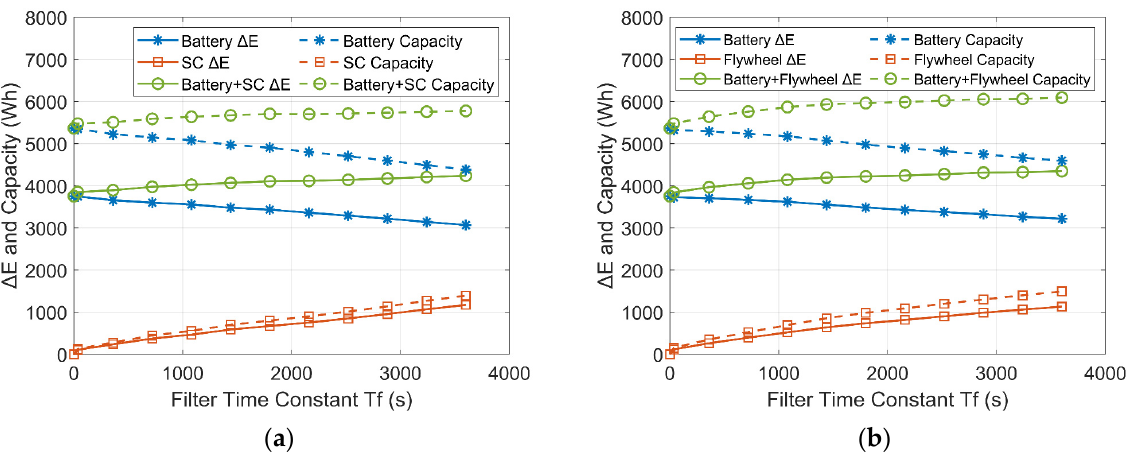
Figure 19. Variations of Δ E and capacities of the ESDs with increasing T f in a PV-powered household-prosumer system. ( a ) Battery-SC HESS. ( b ) Battery-flywheel HESS.